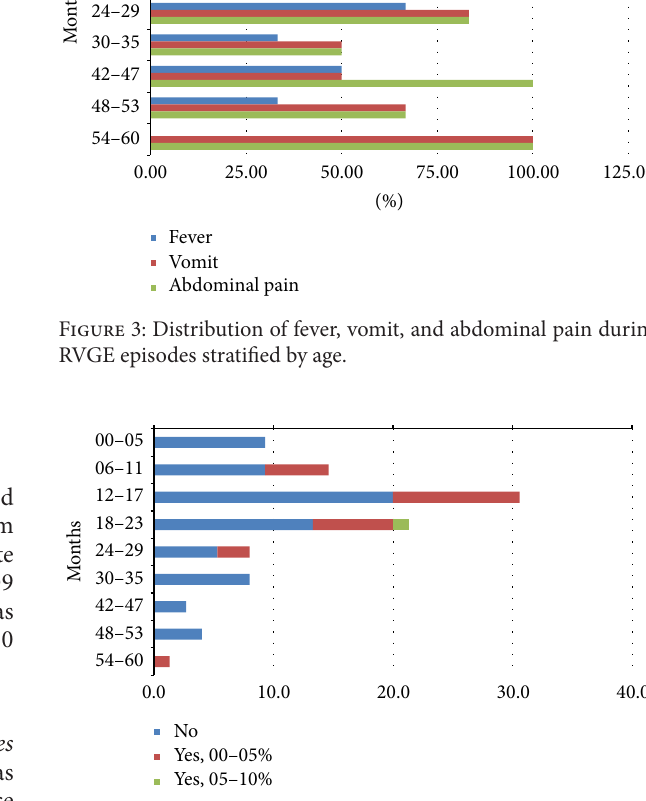
Figure 4: Distribution of dehydration during RVGE episodes stratified by